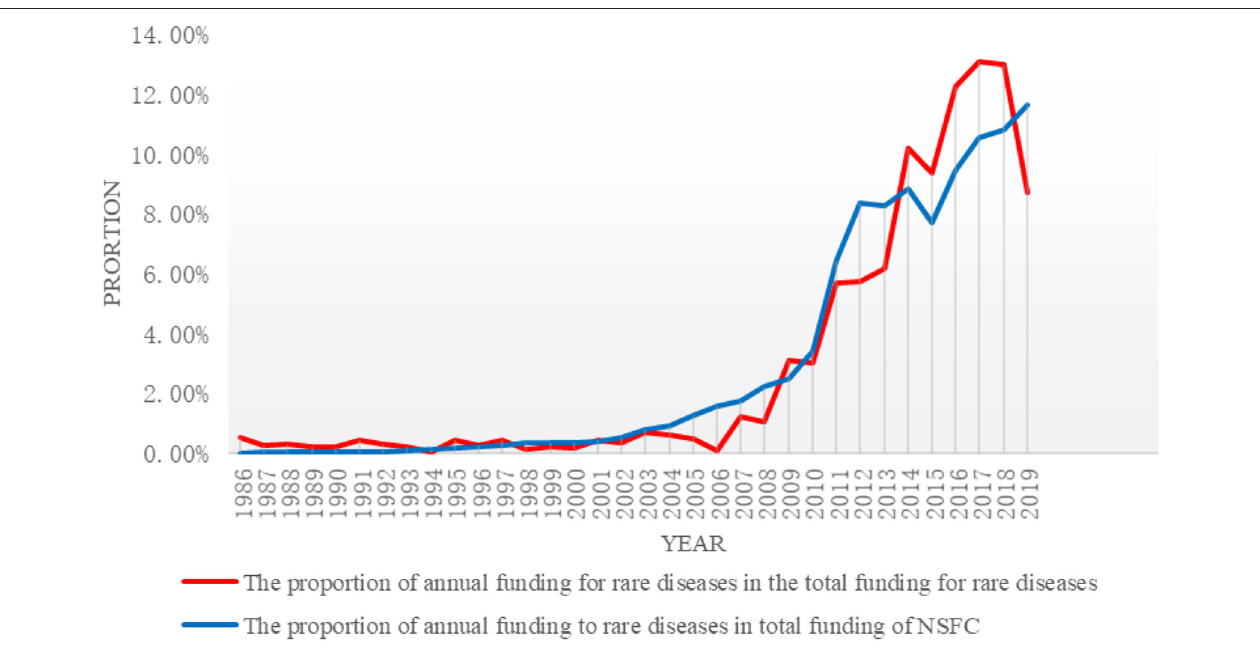
FIGURE 1 | The proportion of funding to rare diseases in the total funding of NSFC and the